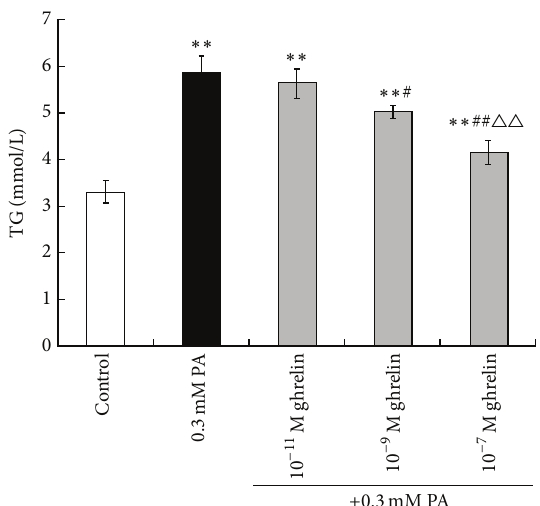
Figure 3: Effects of acylated ghrelin on PA-induced TG accumula- tion in primary cultured rat myoblasts. TG content was measured by the glycerol phosphate dehydrogenase-peroxidase enzymatic method. Data are shown as mean ± standard deviation (SD). ∗∗ 𝑃 < 0.01 versus controls; # 𝑃 < 0.05 , ## 𝑃 < 0.01 versus the 0.3 mM PA group; △△ 𝑃 < 0.01 versus the 0.3 mM PA + 10 −11 M acylated ghrelin group.